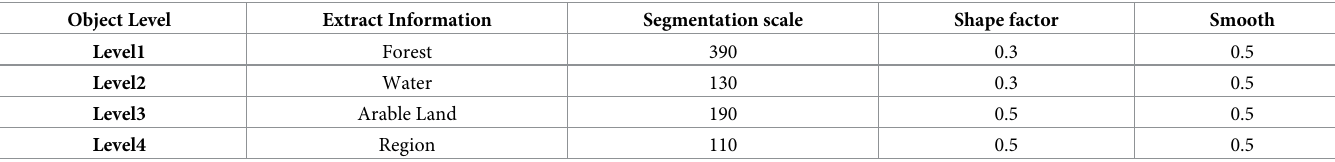
Table 3. Optimal segmentation scale